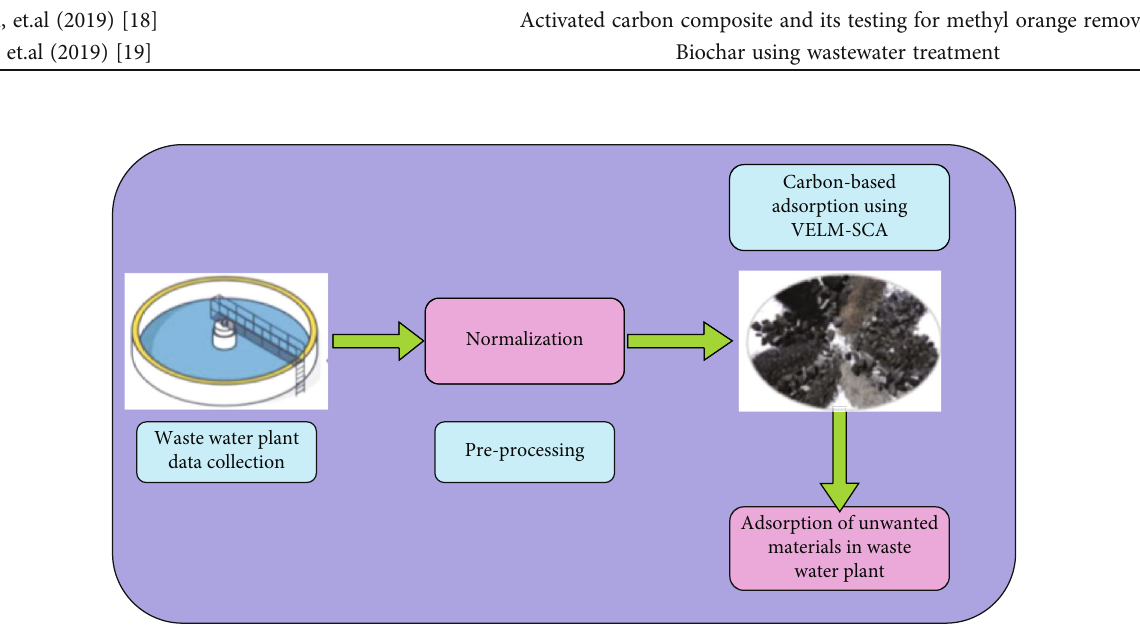
Figure 1: Architecture of